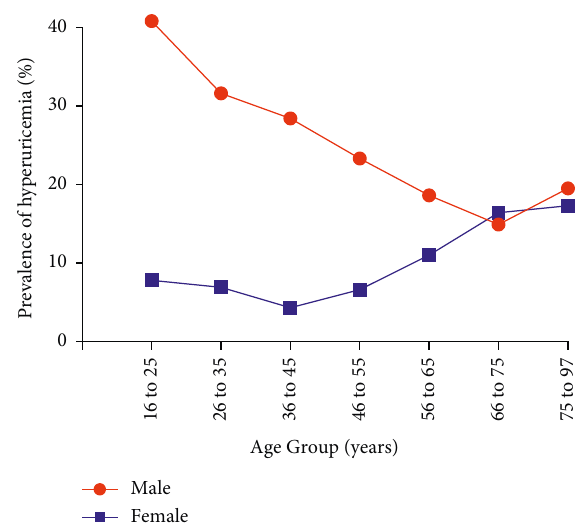
Figure 3: Prevalence of hyperuricemia in different age